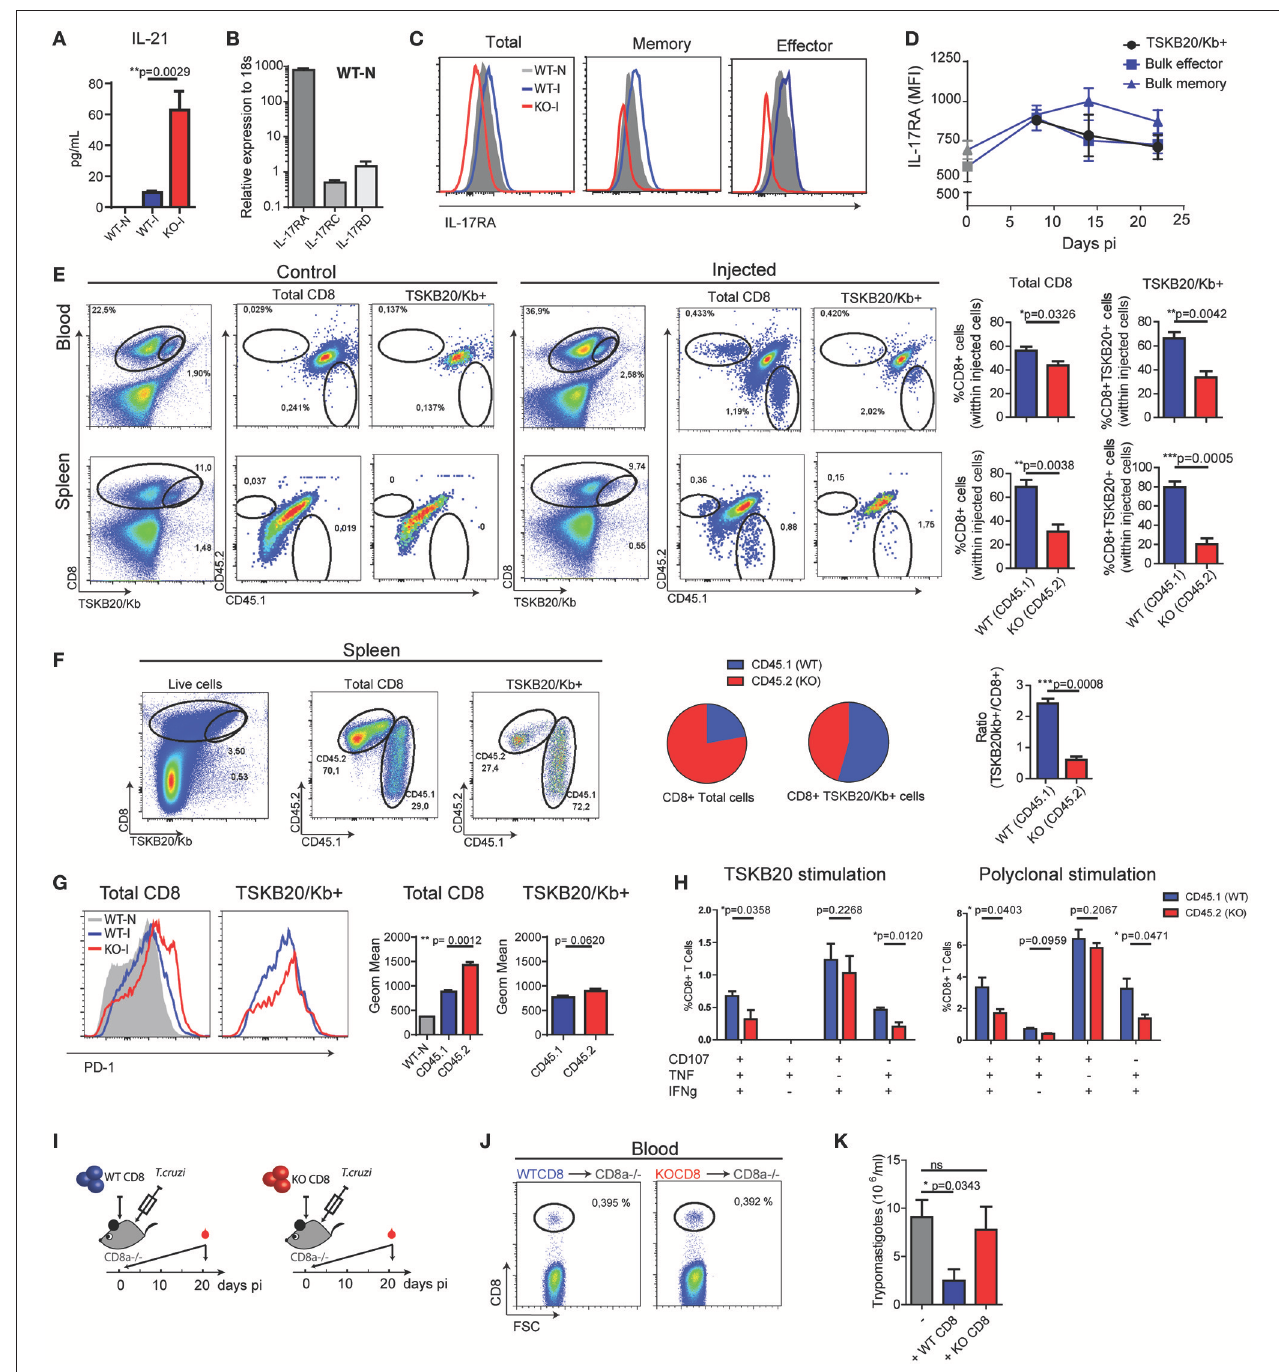
FIGURE 6 | Intrinsic IL-17RA-signaling modulates the maintenance, phenotype and function of CD8 + T cells during T. cruzi infection. (A) Concentration of IL-21 in plasma of infected (20 dpi) WT and IL-17RA KO mice. Data are presented as mean ± SD , N = 4 mice. (B) Amounts of Il17ra, Il17rc, and Il17rd transcript determined in CD8 + T cells purified from the spleen of non-infected WT mice, normalized to 18S RNA. Data are presented as mean ± SD , N = 4 mice (C) Representative histograms of the expression of IL-17RA (protein) on total, memory and effector CD8 + T cell subsets defined according to CD44 and CD62L staining in spleen cell suspensions from non-infected (N) and infected (I) WT mice (14 dpi). Staining of IL-17RA on spleen CD8 + T cells from IL-17RA KO mice is showed as negative control. (D) Kinetic evaluation of the upregulation of IL-17RA (MFI: mean of fluorescence intensity) induced by T. cruzi expression on bulk effector and memory CD8 + T cells and TSKB20-specific CD8 + T cells. Data in statistical analysis are presented as mean ± SD , N = 4. (E) Representative plots and statistical analysis of CD8 and TSKB20/Kb staining and of CD45.1 and CD45.2 staining within Total and TSKB20/Kb + CD8 + T cells in the blood and spleen of infected CD45.1/CD45.2